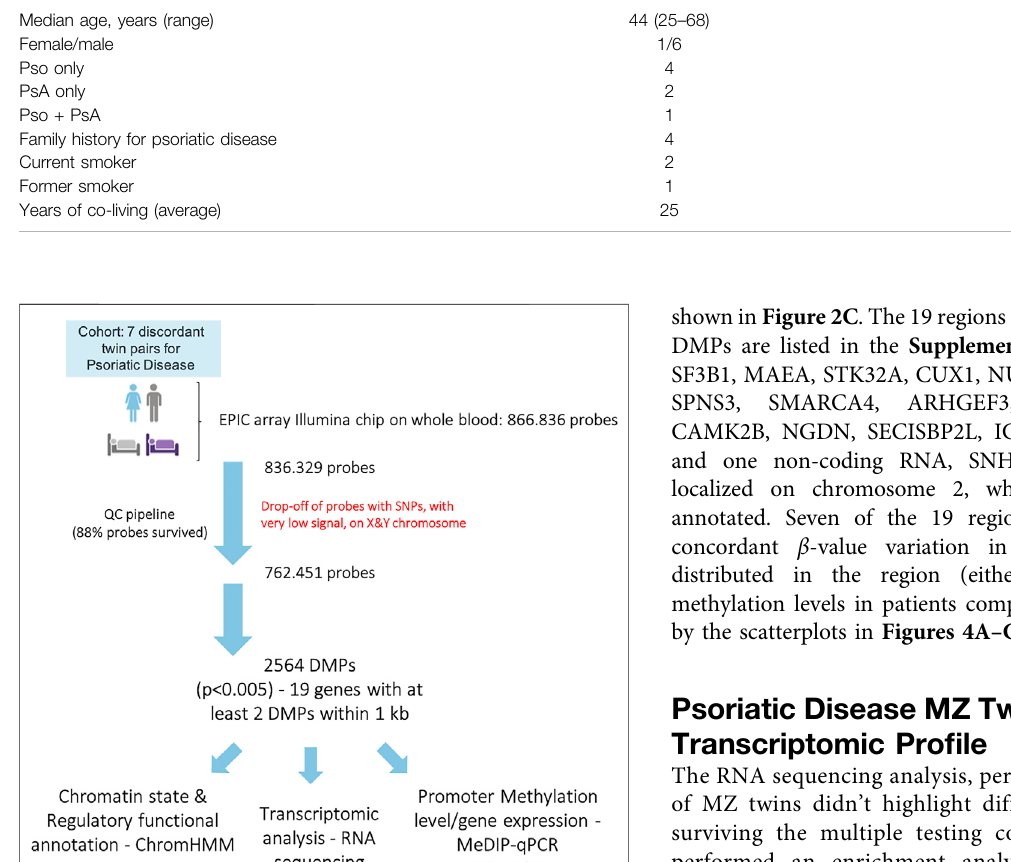
Pso/PsA affected MZ co-twins ( n = 7)